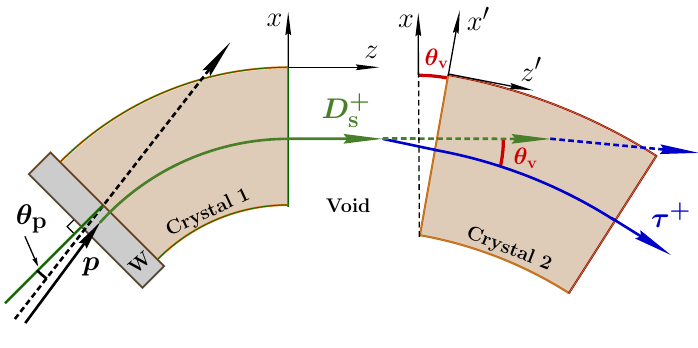
Figure 4 . Double crystal